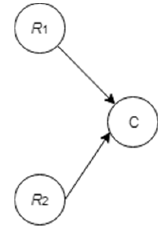
Figure 2. Illustration of static BN.